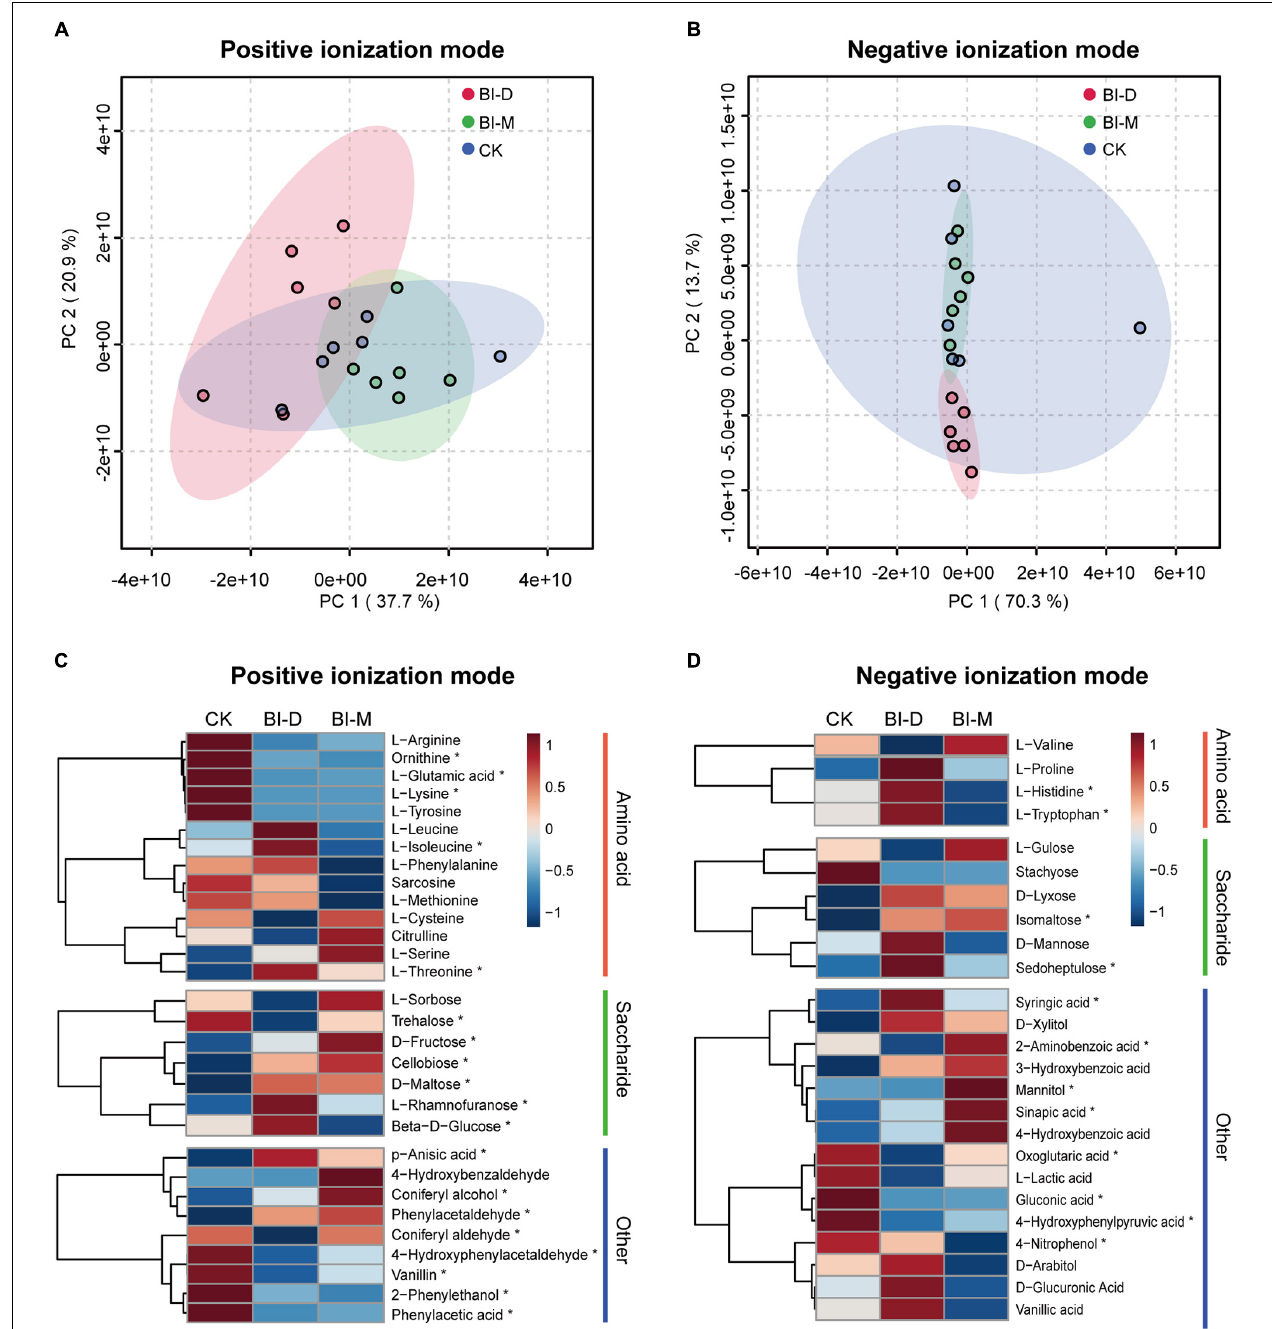
FIGURE 5 | Metabolomic analysis of in vitro degradation of maize particles by two microbial consortia. PCA score plot of metabolic profiles in (A) positive and (B) negative ionization modes. Colored circles represent the metabolic profiles of individual samples. Ellipses indicate 95% confidence region for each group. Relative metabolite levels of maize cellulolytic degradation by two bacterial isolates in (C) positive and (D) negative ionization modes. The color scale shows levels for each metabolite relative to the average abundance. Asterisks indicate significant differences ( P < 0.05) between each group. Summary statistics are provided in Supplementary Table 7